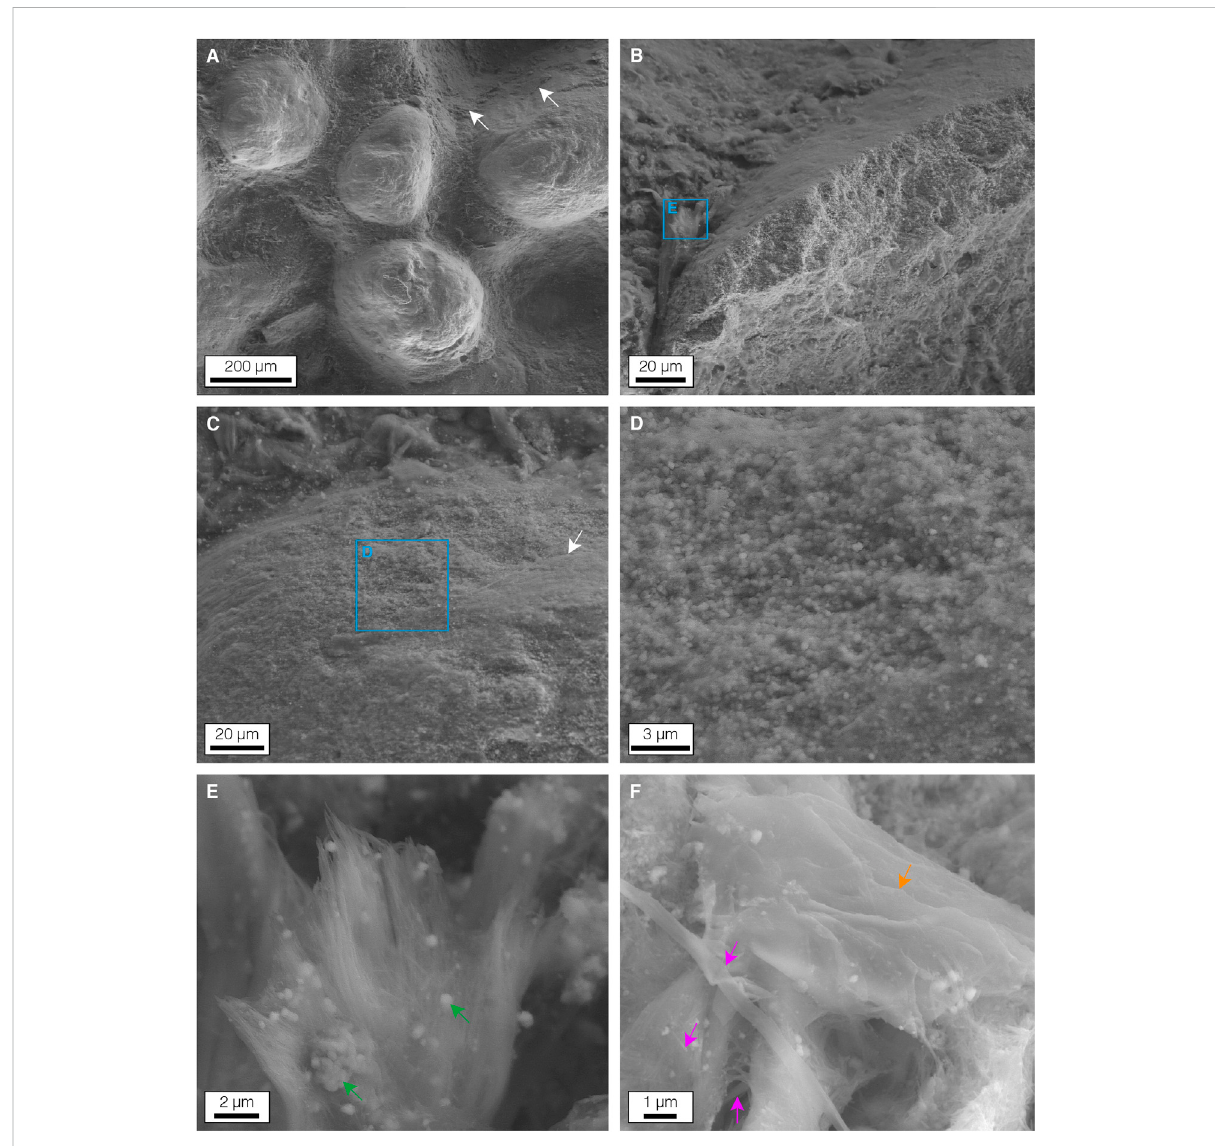
FIGURE 4 SEMimagesinsecondaryelectronmodeofAmizmizphosphorites fromtheMoroccanHigh Atlas. (A) Roundedto slightly elongated phosphate peloidsenclosedina fi nelylaminatedmatrix(arrows). (B) Brokenphosphategrainthatconsistsofdenselypackedcrystallites. (C) Thepeloidsurfaceis splotchy and occasionally draped by clayey layers (arrow). (D) Close up of image (C) . High density of sphere-like phosphate crystallites intertwined with a clayey material fi lling the porosity. (E) Close up of image (B) . Fan-shaped fi ber bundle typical of sepiolite/palygorskite clay minerals. Arrows show the sphere-like phosphate crystallites. (F) Nm- to µm-long sepiolite/palygorskite fi bers (purple arrows) in association with platy phyllosilicates (orange arrow) like smectite